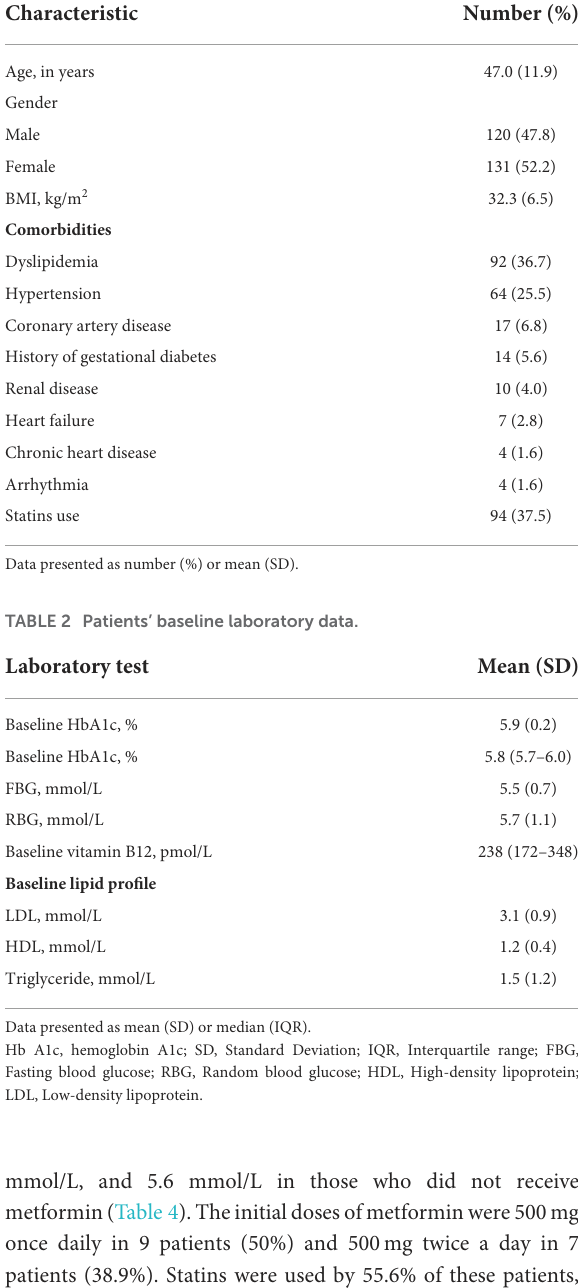
TABLE 1 Patients’ characteristics ( n = 251).